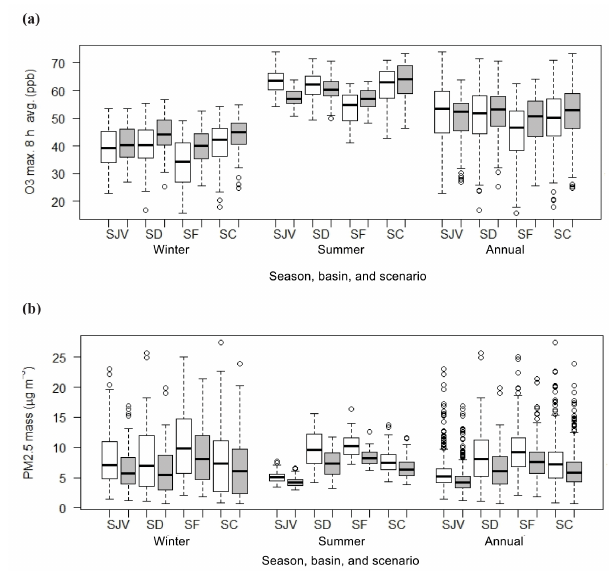
Figure 2. (a) Population-weighted 8h average ozone concentration by region. (b) Population-weighted PM 2 . 5 mass concentration by region. Averages are shown for the winter, summer, and annual time periods in the year 2054. SJV, SD, SF, and SC represent the San Joaquin Valley, San Diego, San Francisco, and South Coast, respec- tively. A P value<0.0001 was found for each difference between concentrations calculated with the BAU emissions (white bars) ver- sus the GHG-Step emissions (gray